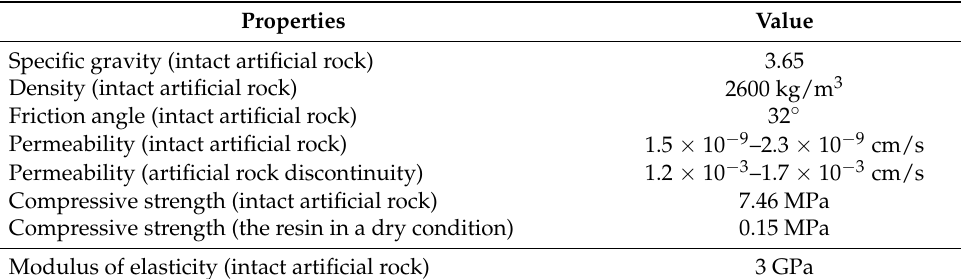
Figure 5. Rock wedge (oblique slope) model comprising grinding stones and resin. Table 1. Material properties for the physical models.